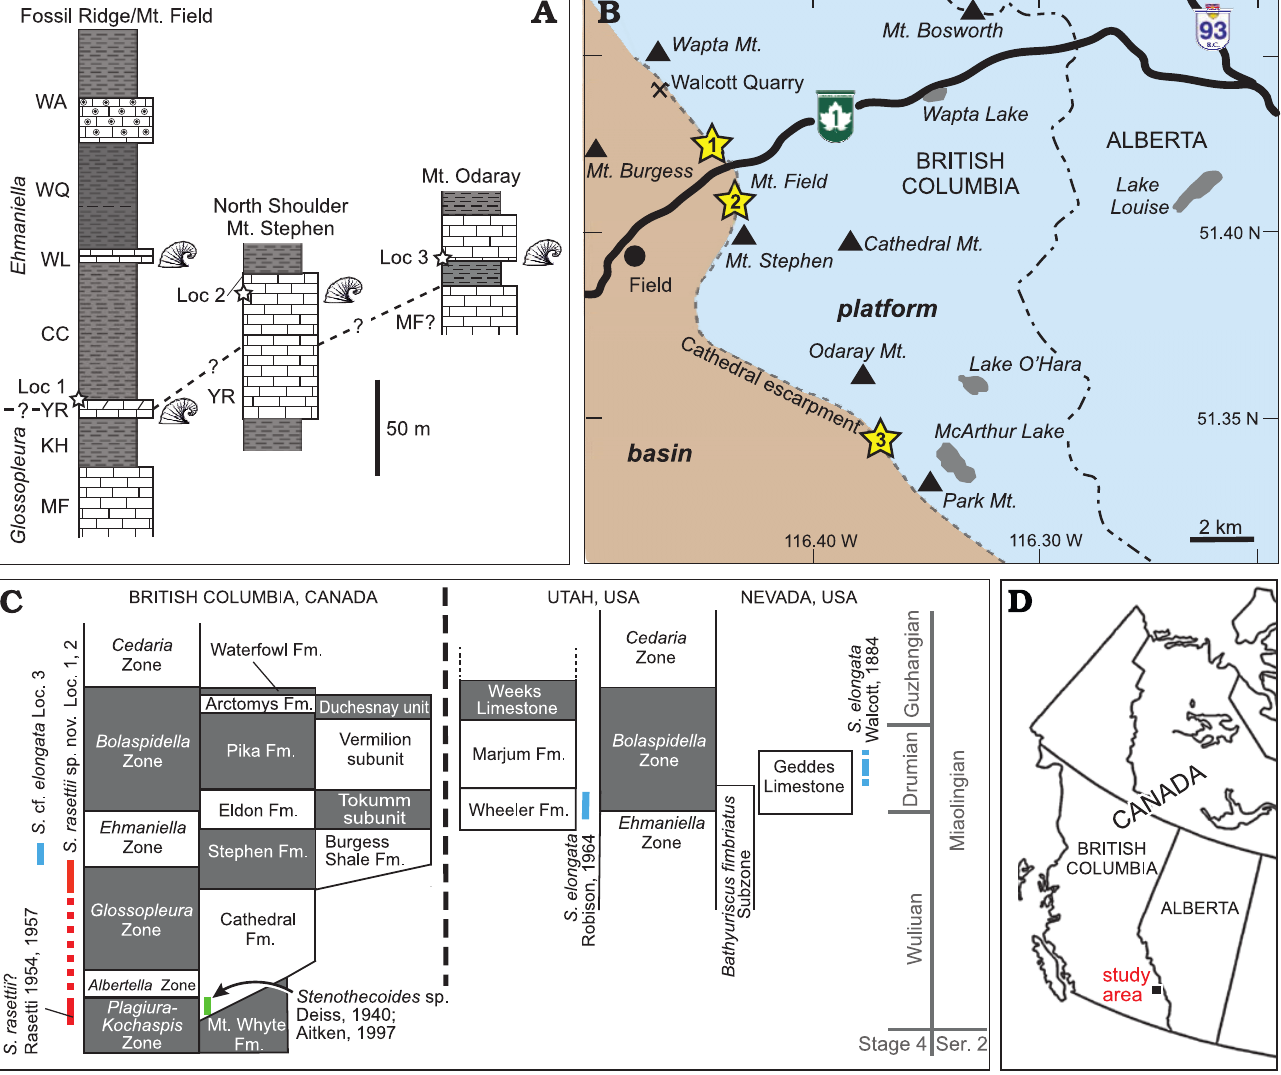
Fig. 2. Stratigraphic and geographic distribution of sample localities. A . Stratigraphic position of localities 1–3 indicated with stars. Thicknesses of units at Fossil Ridge/Mount Field from Fletcher and Collins (1998) and Mount Stephen northwest shoulder from Christopher J. Collom and PAJ (unpublished data); stratigraphic units after Collom et al. (2009), Odaray Mountain section from Streng et al. (2016). Helcionellid icons show known silicified assem- blages. B . Geographic distribution of localities 1–3 relative to the Cathedral escarpment. C . Known stratigraphic distribution of stenothecoids in British Columbia, Utah, and Nevada. Stratigraphy modified from Johnston et al. (2009a). D . General location of study area in western Canada. Abbreviations: CC, Campsite Cliff Shale Member; Fm., Formation; KH, Kicking Horse Shale Member; Loc, Locality; MF, Monarch Formation; Mt., Mount or Mountain; S. , Stenothecoides ; WA, Wapta Member; WL, Wash Limestone Member; WQ, Walcott Quarry Shale Member; YR, Yoho River Limestone